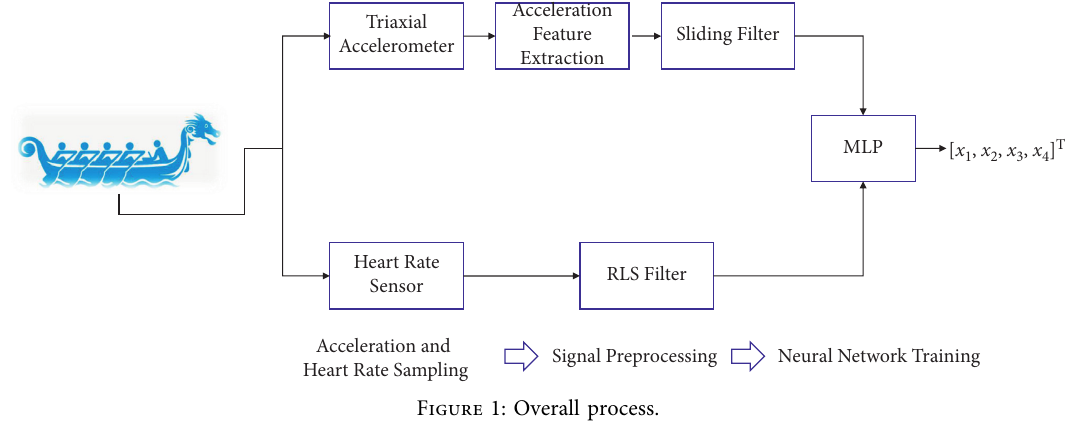
Figure 1: Overall process.